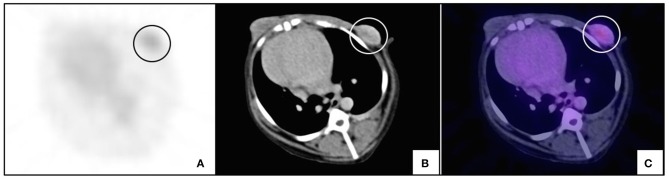
18F-FDG-PET/CT of a malignant canine mammary gland tumor. An intact 14-year old female Poodle-mix, with multiple mammary tumors. The figure shows the same transversal slice by (A) PET; (B) CT, and (C) fusion images of a 3 cm carcinoma-mixed type tumor (circle) (SUVmax: 2.12).